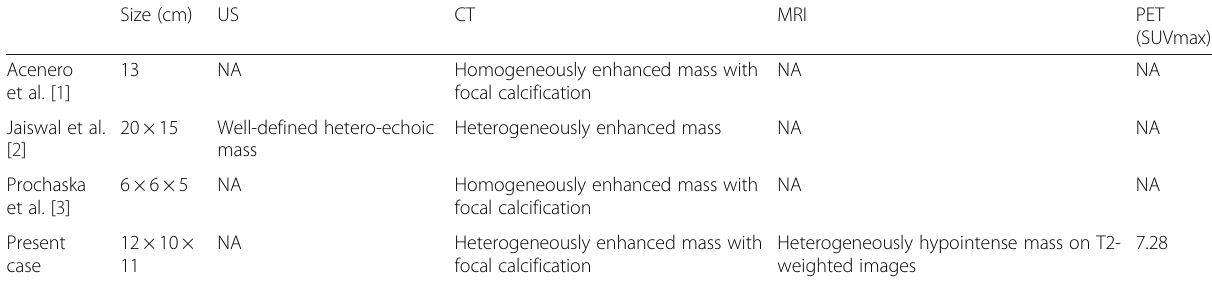
Table 1 The imaging findings of retroperitoneal calcifying fibrous tumor Size (cm)